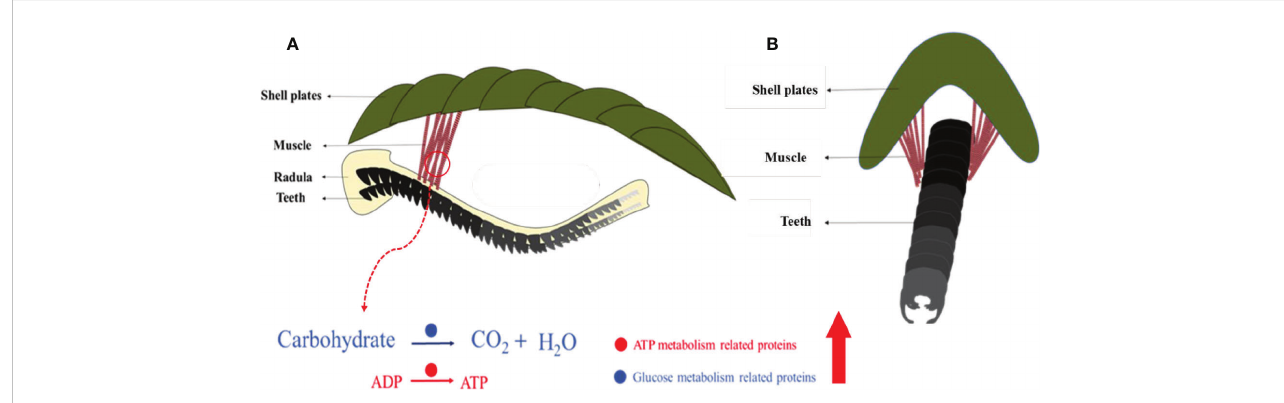
FIGURE 8 Schematic images of complex muscles and their relationship with the radula. Coronal (A) and sagittal (B) view. Molecules that are abundant in muscles are related to glucose metabolism and ATP